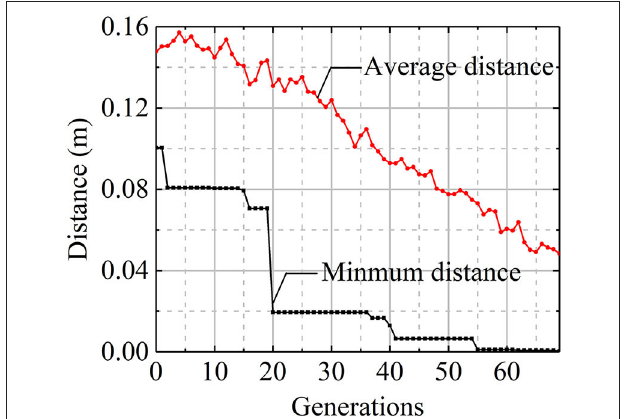
FIGURE 9 | Evolution process of motion path planning.